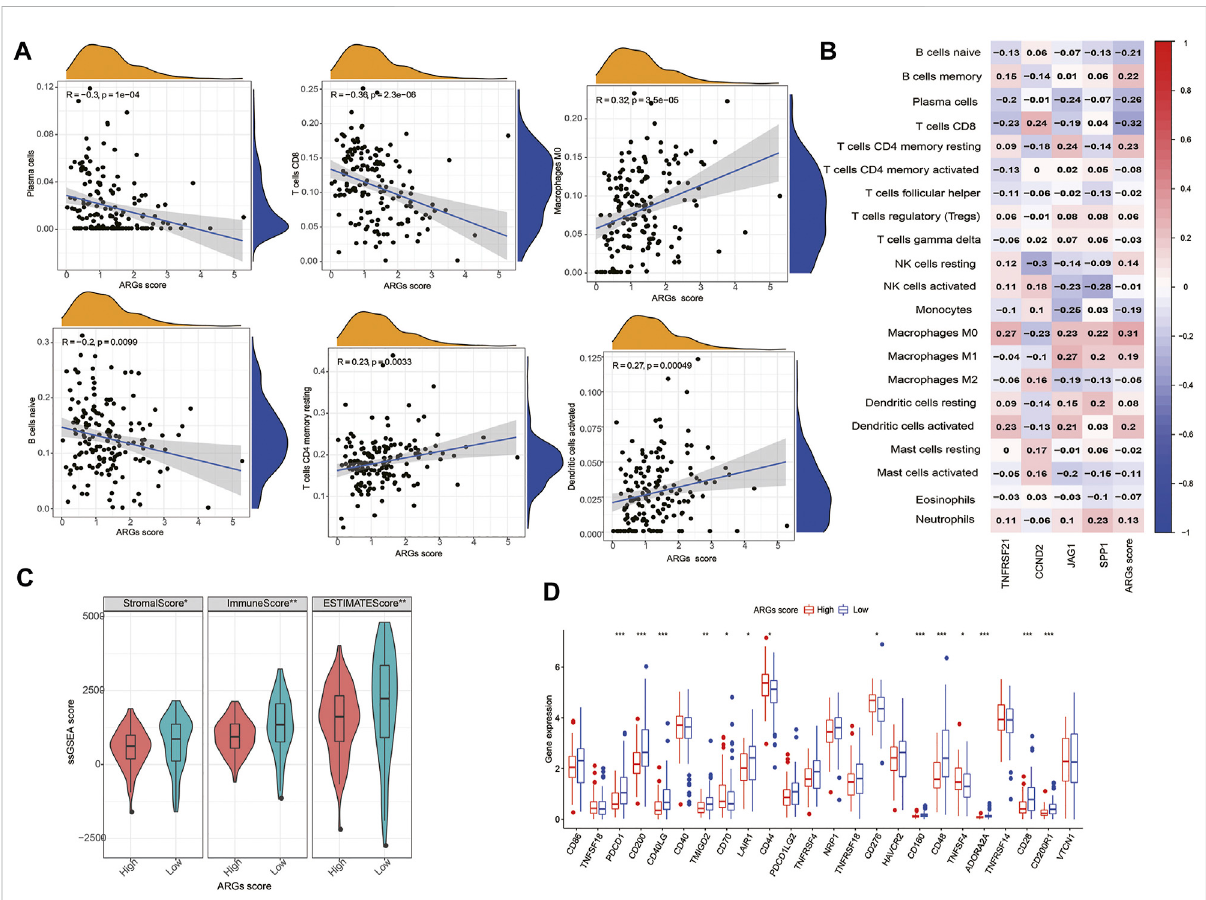
FIGURE 6 EvaluationoftheTIMEandcheckpointsbetweenthetwogroups: (A) CorrelationsbetweenARGsscoreandimmunecelltypes; (B) Correlations betweentheabundanceofimmunecellsandfourgenesintheproposedmodel; (C) CorrelationsbetweenARGsscoreandbothimmuneandstromal scores; (D) Expression of immune checkpoints in the high and low-risk groups. ***p < 0.001, **p < 0.01, *p < 0.05 and not signi fi cant (p > 0.05) by repeated measures with the Wilcoxon test.